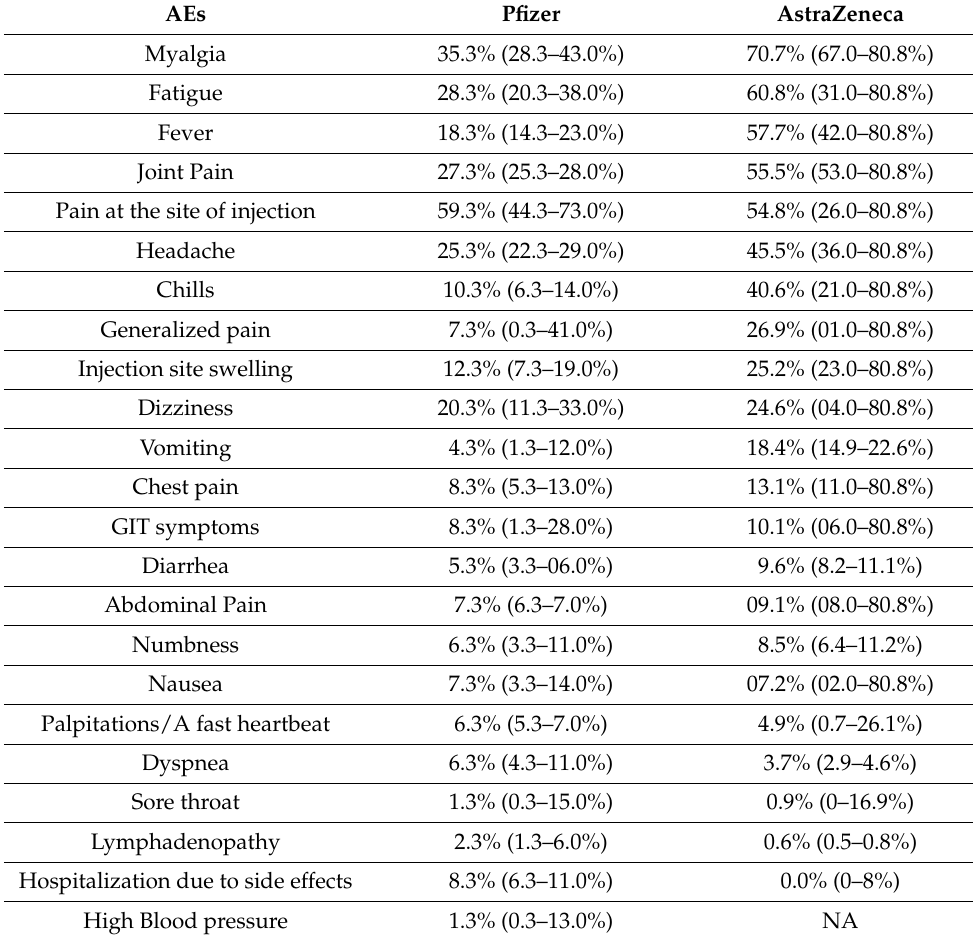
Table 2. Most common local and systemic AEs in both